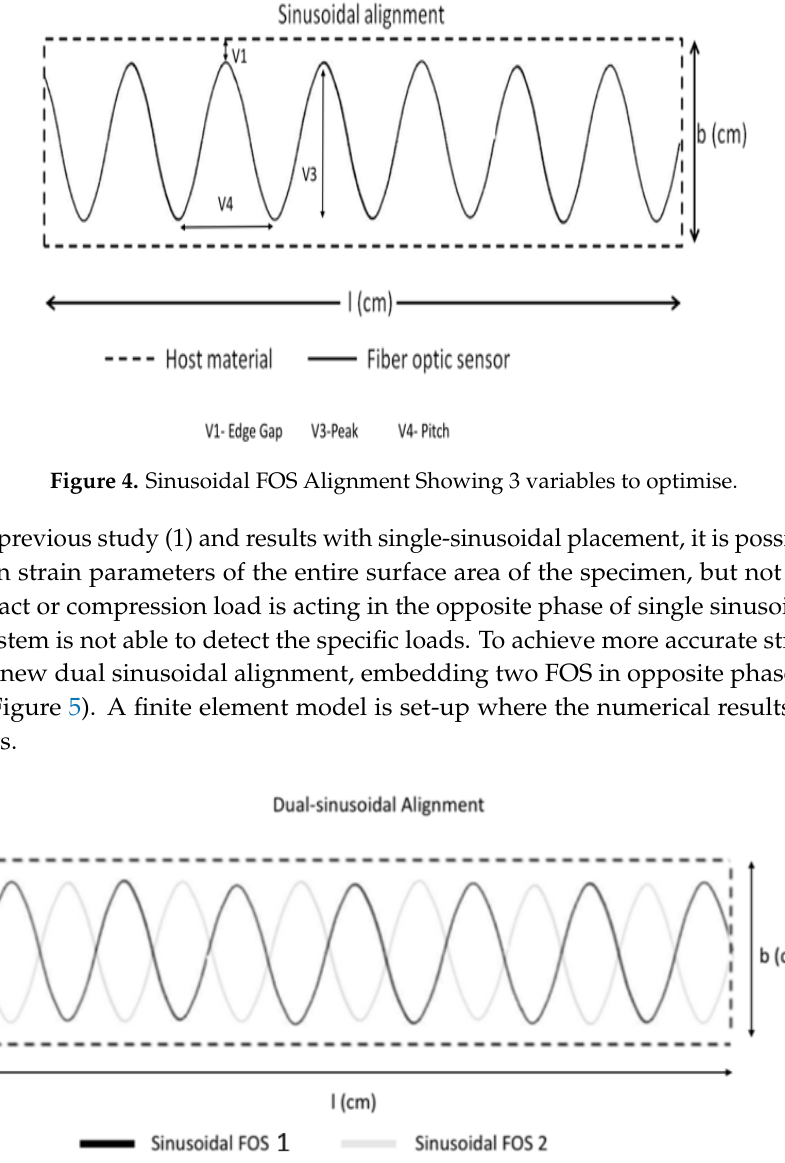
Figure 5. Dual-Sinusoidal FOS Figure 5 . Dual-Sinusoidal FOS Alignment. Figure 5 . Dual-Sinusoidal FOS Alignment.